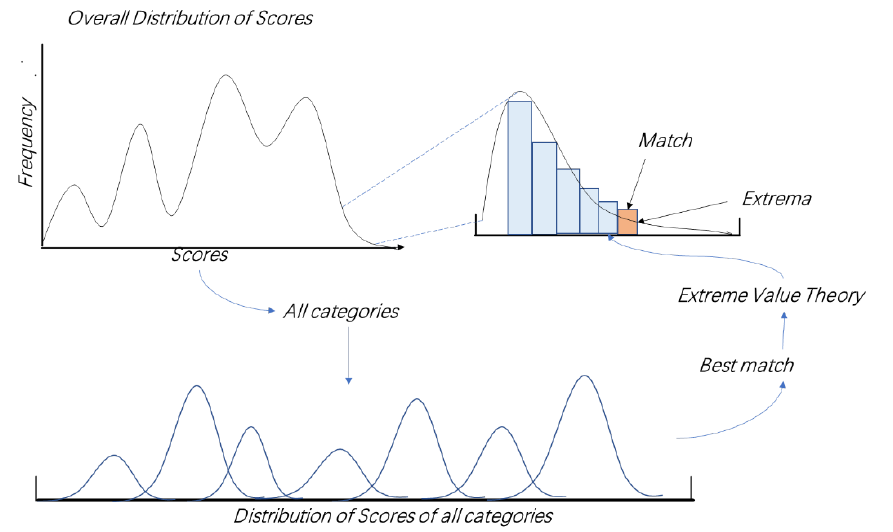
Figure 1. Sample score distribution generated by multi-class binary classifier.